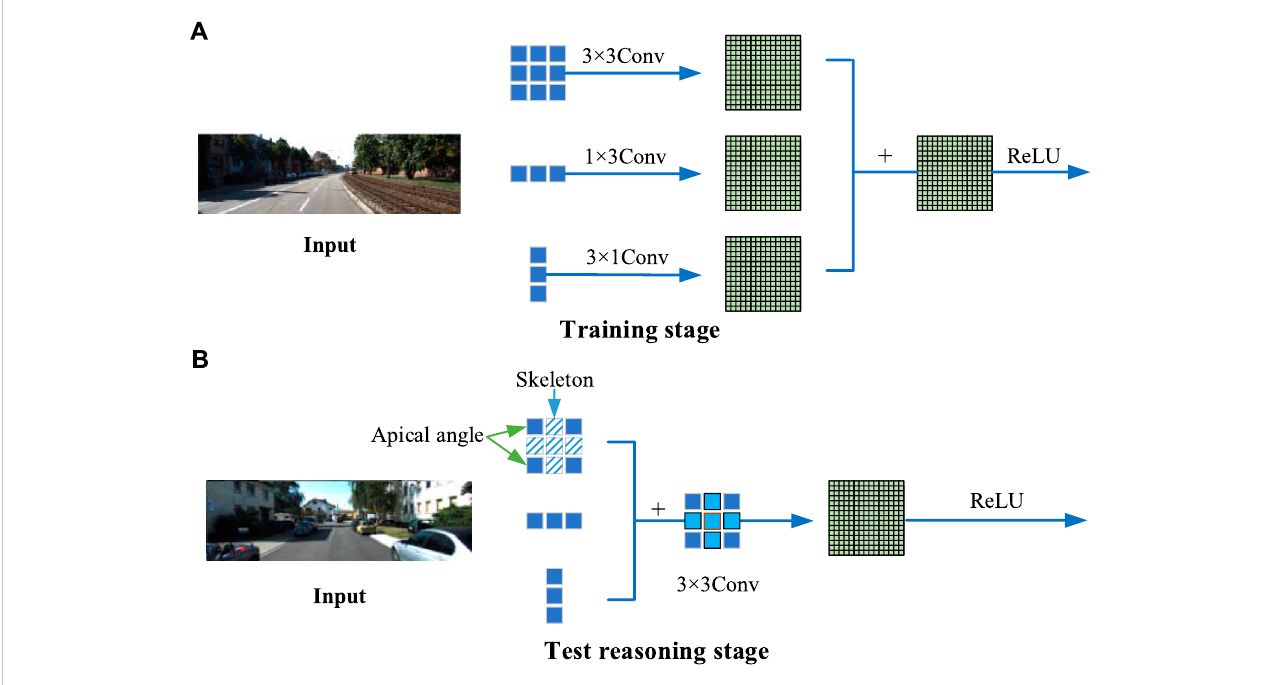
FIGURE 3 Asymmetric convolution structure: (A) The ACNet structure in the training stage; (B) The network structure in the test reasoning stage.